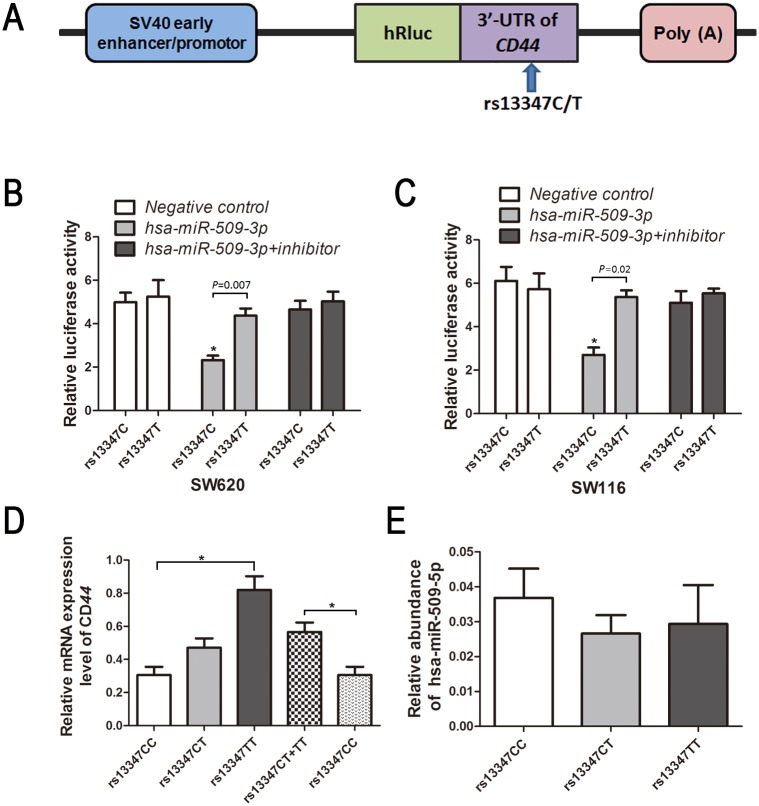

(A) Representative graph of luciferase activity of variant allele on luciferase reporter genes bearing the 358bp of 3’-UTR fragment of the human CD44 gene flanking the rs13347C/T polymorphism. Relative luciferase activity of the psiCHECK2-CD44-rs13347C and psiCHECK2-CD44-rs13347T constructs cotransfected with or without 40pmol hsa-mir-509-3p or 40pmol hsa-mir-509-3p inhibitor, respectively performed in SW260 cells (B) and SW116 cells (C). Six replicates were carried out for each group, and the experiment was repeated at least three times. Asterisk indicates a significant change (P<0.05). Data are mean±SEM. (D)
CD44 expression level in 37 CRC tissues from individuals with different rs13347C/T genotypes (15 rs13347CC, 16 rs13347CT and 6 rs13347TT); CD44 expression was normalized to the GAPDH gene and presented as mean ± SEM. Data shown are representative of at least three independent experiments. (E) The expression level of hsa-miR-509-3p in 37 CRC tissues grouped by rs13347C/T genotypes. The hsa-miR-509-3p mRNA expression was calculated relative to expression of U6 mRNA by calculating the relative expression levels. Data are mean±SEM, P = 0.579. The differences in the expression levels were analyzed with one-way ANOVA test.